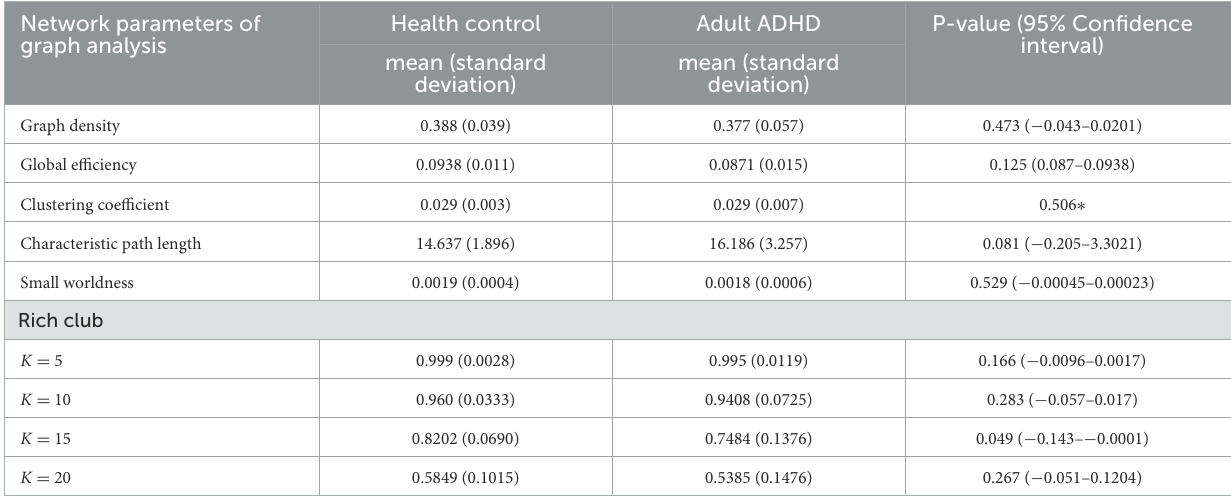
TABLE 2 Results of graph theoretical